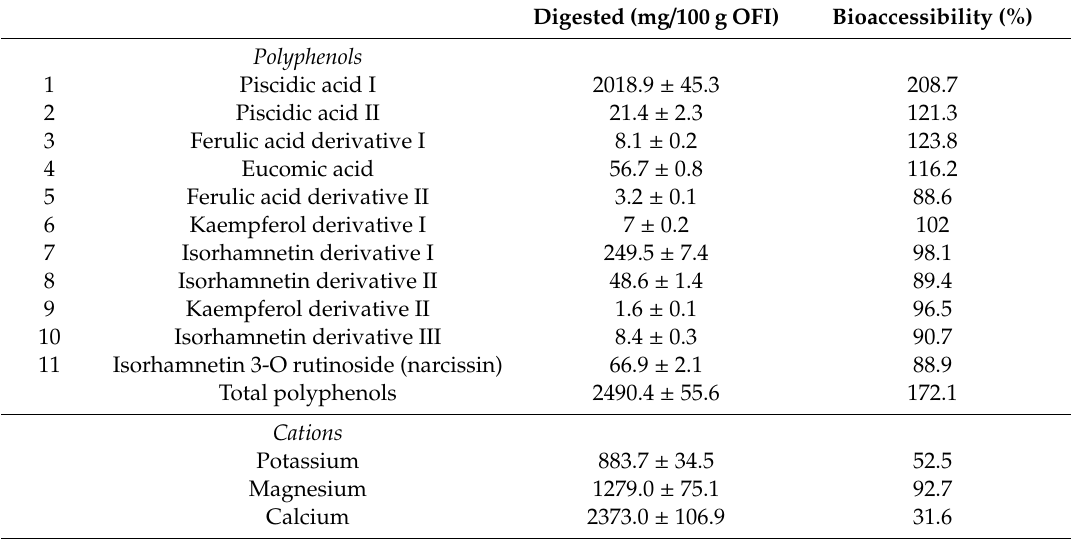
Table 5. Digested composition and bioaccessibility of polyphenols and cations from Opuntia ficus indica cladodes (OFI), after in vitro gastrointestinal digestion. Results are expressed as mean ± standard deviation ( n =